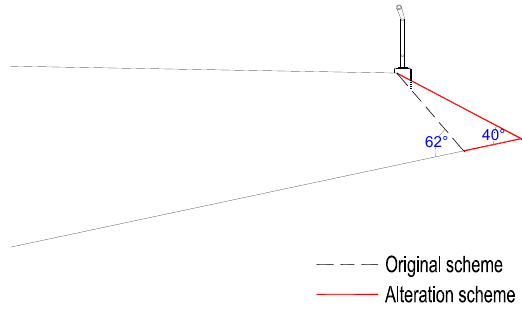
Figure 10. Aerodynamic measures.